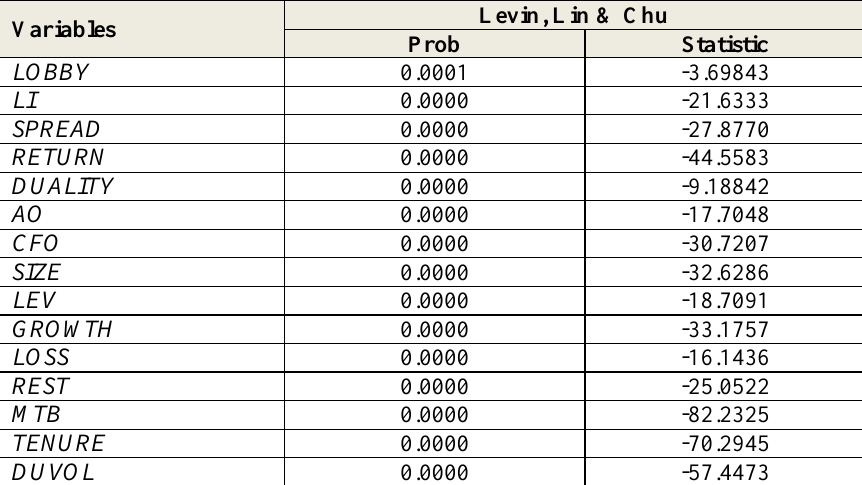
Table 9: Panel unit root test